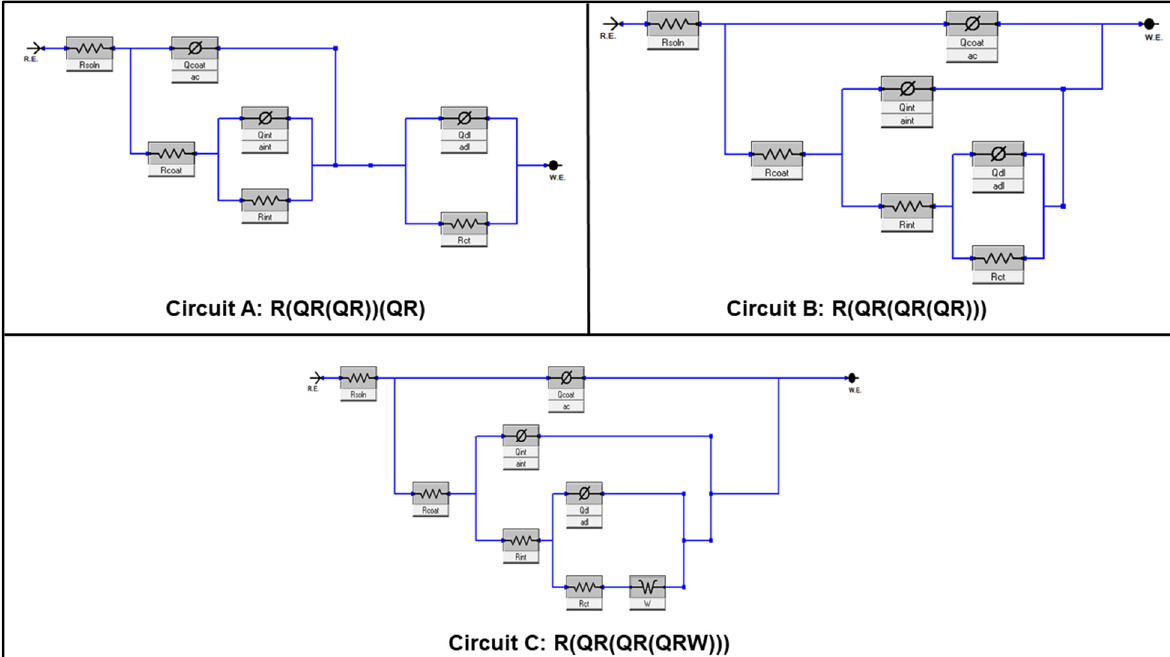
Figure 9. Electrochemical equivalent circuits used in fitting the EIS data of the coating matrices on AA3003 substrate.